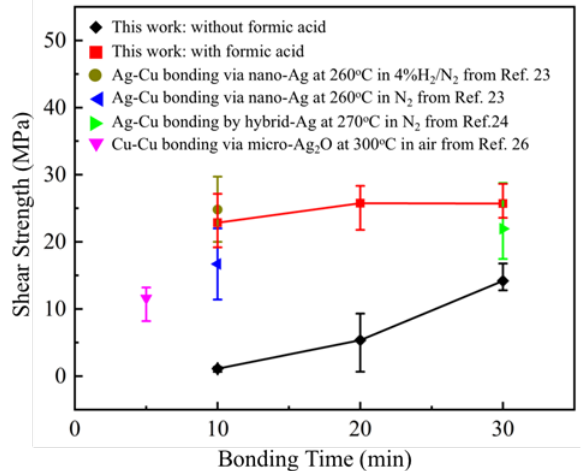
Figure 5. Shear strength of the Ag-Cu bonding at 160 °C under 3 MPa for 10 min, 20 min, and 30 min with and without the formic acid vapor. The referred strength results of the joints bonded at temperatures higher than 250 °C are from the literature [23,24,26].